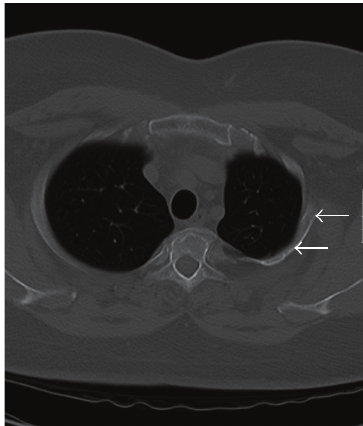
Figure 2: 43-year-old gentleman complaining of high grade fever, cough, and chest pain was investigated with chest radiographs and helical chest CTscan and subsequently diagnosed with intrathoracic ribs. Unenhanced axial chest CT scan (bone window) shows depressed left third intrathoracic rib (arrows) and hypoplastic upper lobe of the left